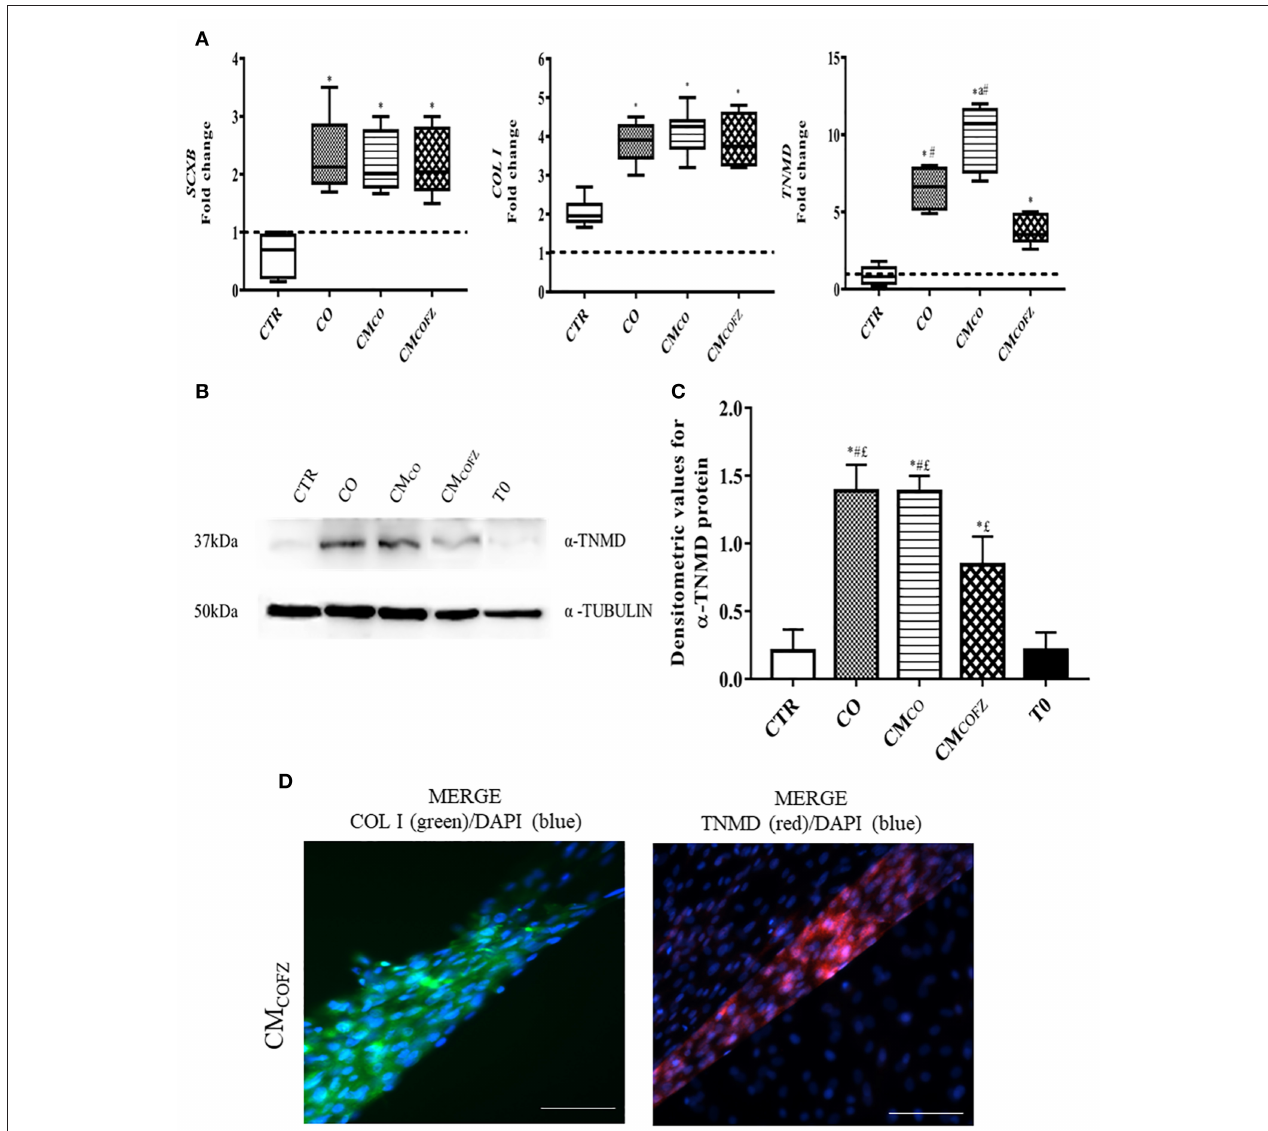
FIGURE 4 | Evaluation of tenogenic potential CM COFZ on AECs after 14 days of culture. (A) Real time qPCR analysis for SCXB, COL I , and TNMD tendon related genes in AECs cells cultured for 14 days in different experimental conditions. Relative quantification of each mRNA gene expression normalized to endogenous GAPDH (internal control) was calculated using the 11 Ct method and presented as fold change over the AECs T0 = 1 (calibrator; dashed line). Values were considered significant when p < 0.05, with superscripts *vs. CTR, a vs. CO, # vs. CM COFZ . (B) Representative Western Blot image for α -TNMD and α -TUBULIN proteins expression on different experimental conditions. (C) α -TNMD protein quantification normalized on α -TUBULIN expression levels and expressed as means ± S.D of three replicates/each experimental condition. Values were considered significant when p < 0.05, with the indicated superscripts *vs. CTR, # vs. CM COFZ , £ vs. T0. (D) Representative IHC images for COL I (green color) and TNMD (red color) protein expression in AECs after 14 days of culture under CM COFZ experimental condition. Nuclei were counterstained with DAPI (blue color). Magnification 20X, scale bar: 100 µ